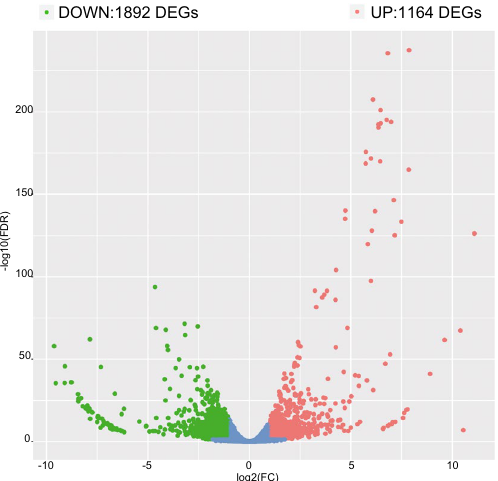
Figure 1. Heatmap illustration of differentially expressed genes (DEGs). Red and green circles indicate up-regulated and down-regulated DEGs,